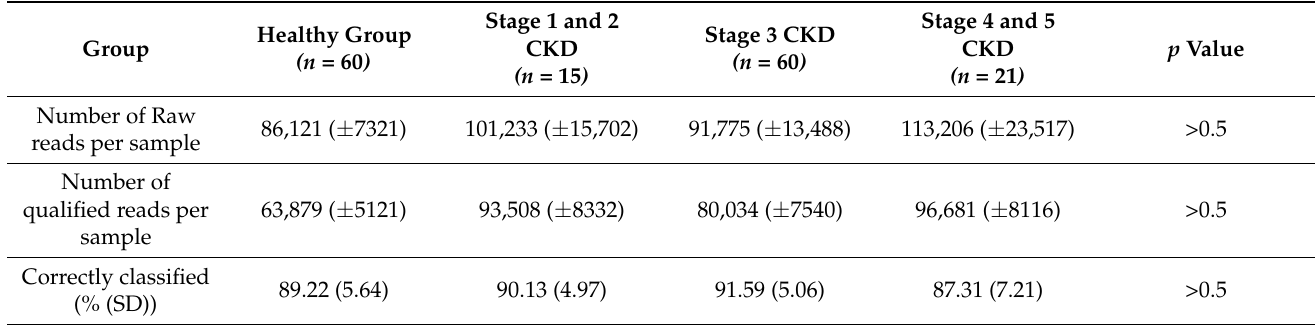
Table 2. Summary statistics of long-read sequencing results.